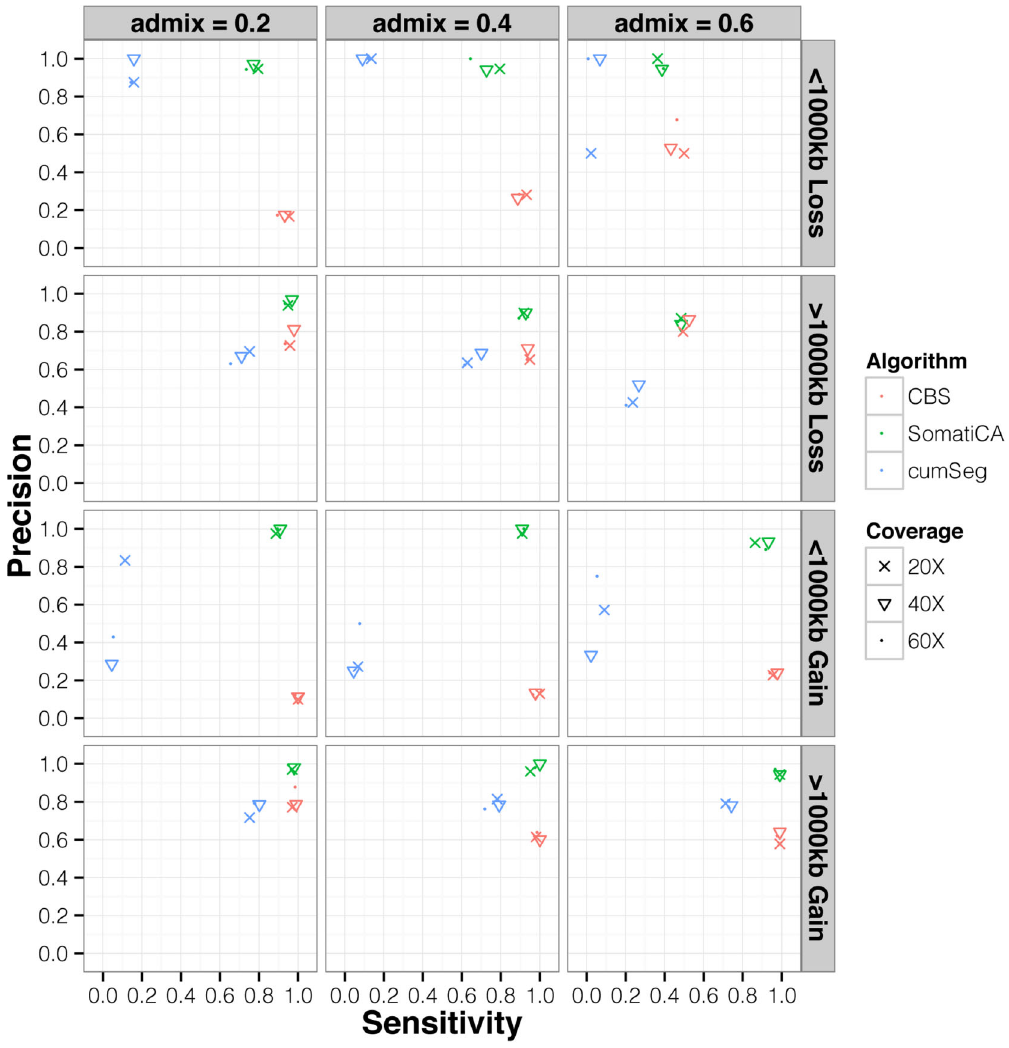
Figure 2. Precision Vs. Sensitivity comparison of three segmentation methods. Summary of precision and sensitivity over 90 simulated cancer genomes with different admixture rates and coverage. CBS and SomatiCA outperformed cumSeg in sensitivity at detecting SCNAs larger than 1 Mb. However, CBS had 30% false positive calls whereas SomatiCA achieved higher precision. For SCNAs smaller than 1 Mb, CBS still maintained a high sensitivity of 98% but over 60% of CBS calls were false positives. Both SomatiCA and cumSeg used model selection to effectively reduce the false positive rate with some compromise on sensitivity.